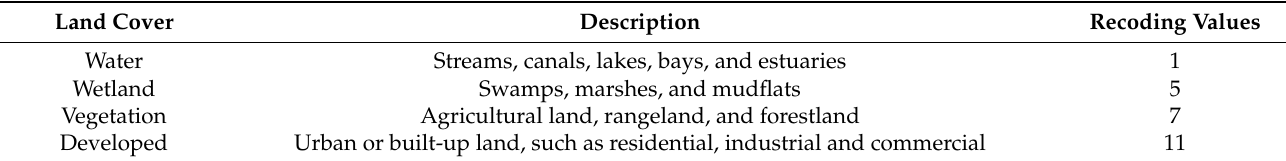
Table 2. Land cover types, descriptions, and their recoded values.